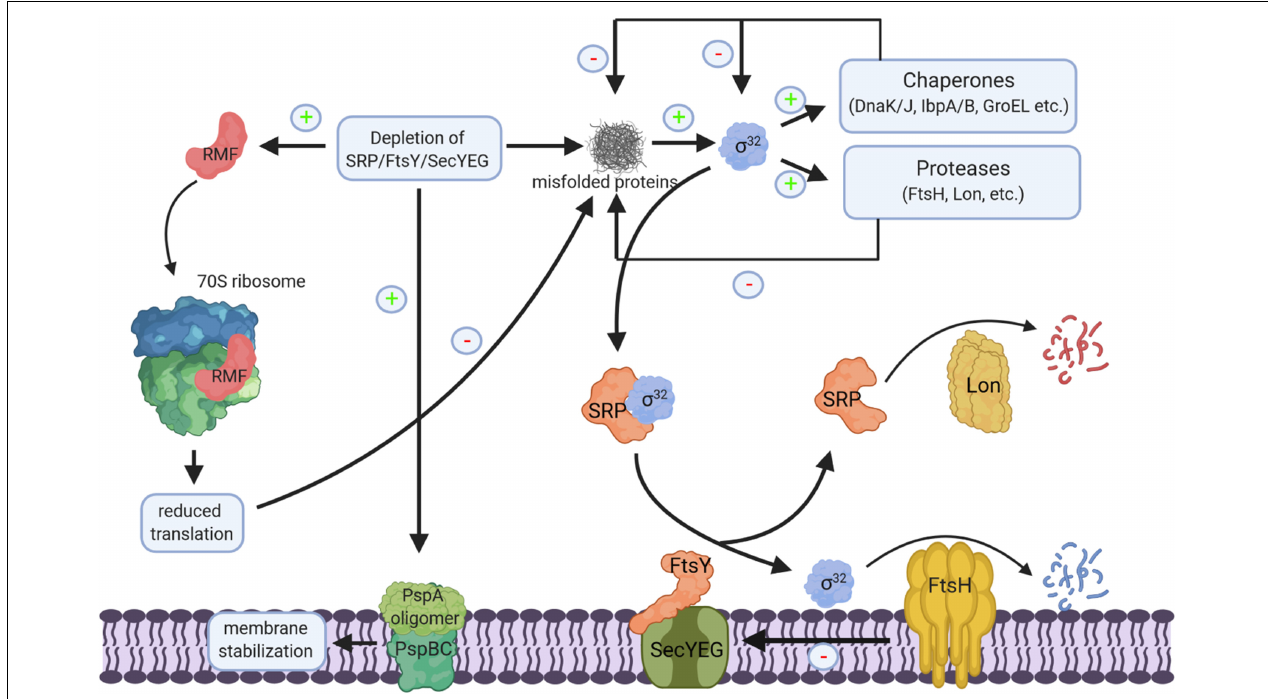
FIGURE 11 | Cellular response to impaired protein transport. Depletion of SRP/FtsY or SecYEG induce a multifaceted response. This includes membrane stabilization via the induction of the phage-shock response (PspABC complex), the inhibition of translation via the induction of the ribosome-modulation factor (RMF) upon FtsY depletion and the induction of the σ 32 -response via the accumulation of misfolded proteins. Increased chaperone and protease production reduce the cellular concentration of misfolded proteins and provide a negative feedback loop for declining the σ 32 response. Chaperones inhibit σ 32 directly and the membrane bound protease FtsH degrades σ 32 . Membrane targeting of σ 32 for degradation by FtsH is dependent on SRP/FtsY and SecYEG. Thus, upon SRP/FtsY or SecYEG depletion/saturation, elevated σ 32 levels persist. FtsH also degrades misfolded/aggregated membrane proteins and SecY that is not in complex with its partner protein SecE. Ffh, the protein subunit of SRP is also a substrate of the Lon protease; in particular when Ffh is in excess over the 4.5S RNA, the RNA subunit of the bacterial SRP. “+” indicates increased production, “–” indicates reduced production, inhibition or degradation.